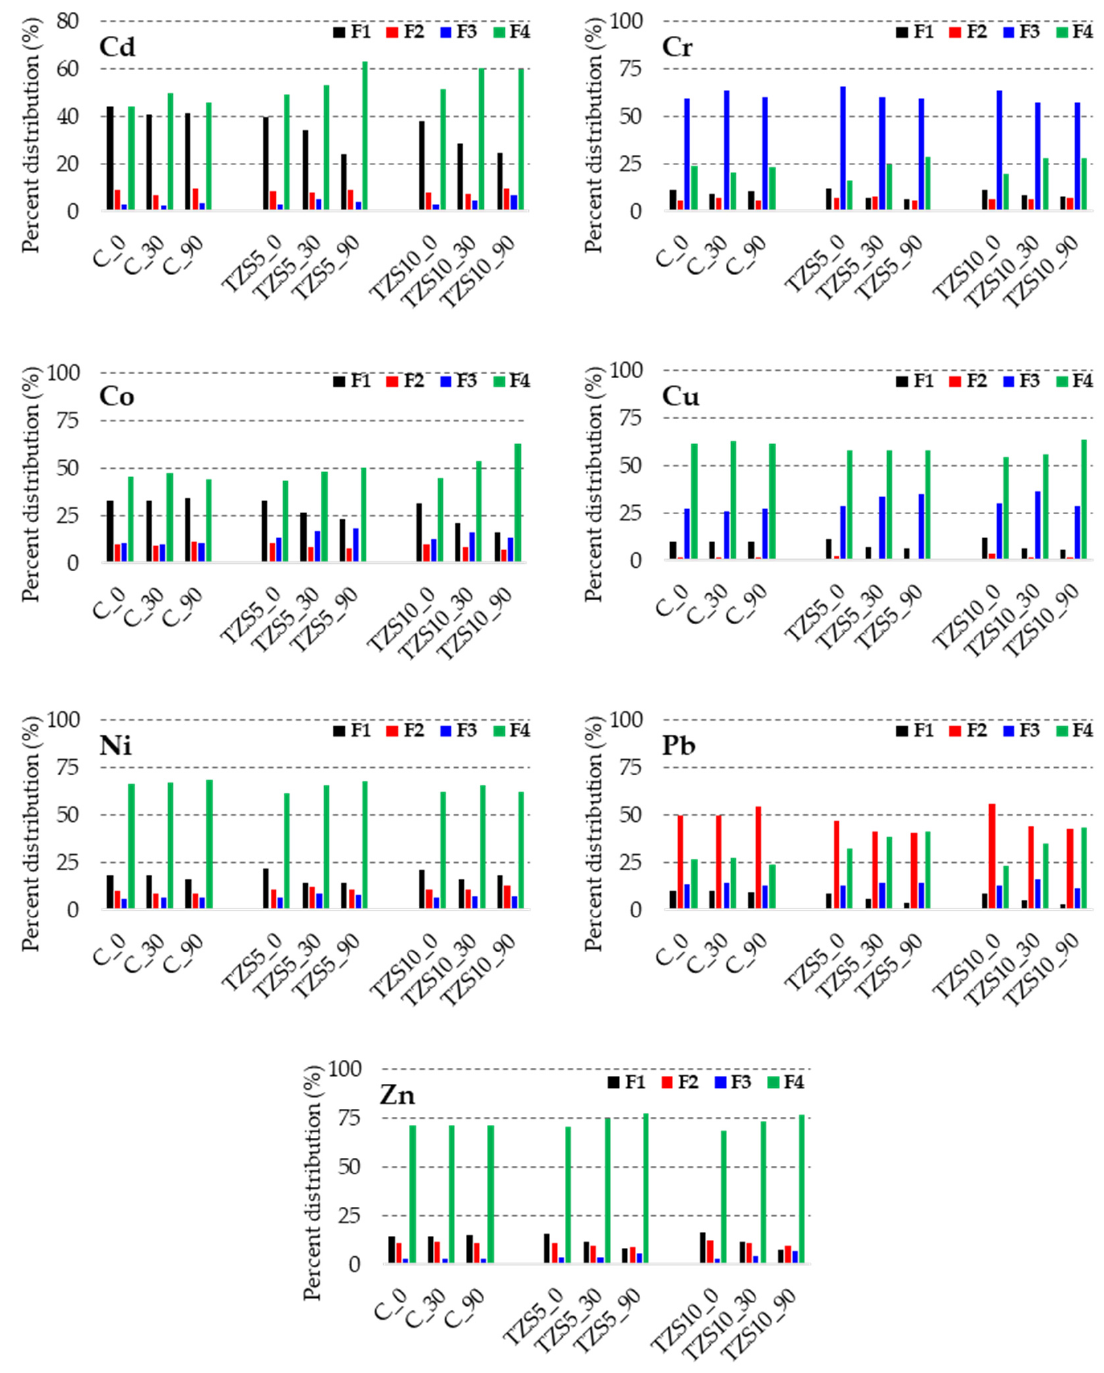
Figure 2. Percentage distribution of potentially toxic elements (PTE) concentrations in exchangeable and weak acid soluble fraction (F1), reducible fraction (F2), oxidizable fraction (F3) and residual fraction (F4) in the control soil (C) and soil amended with 5% (TZS5) and 10% (TZS10) zeolite at 0, 30, and 90 days after amendment.